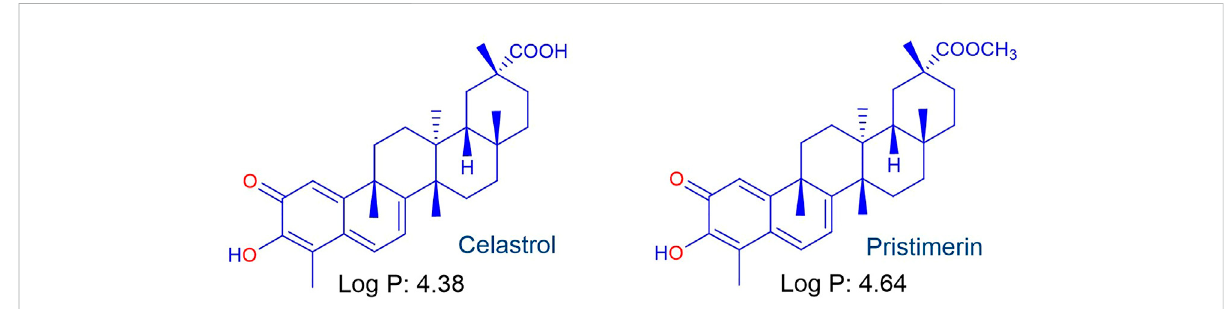
FIGURE 4 The lipophilic pentacyclic triterpene celastrol isolated from Tripterygium wilfordii used in Traditional Chinese Medicine and the naturally- occurring methyl ester